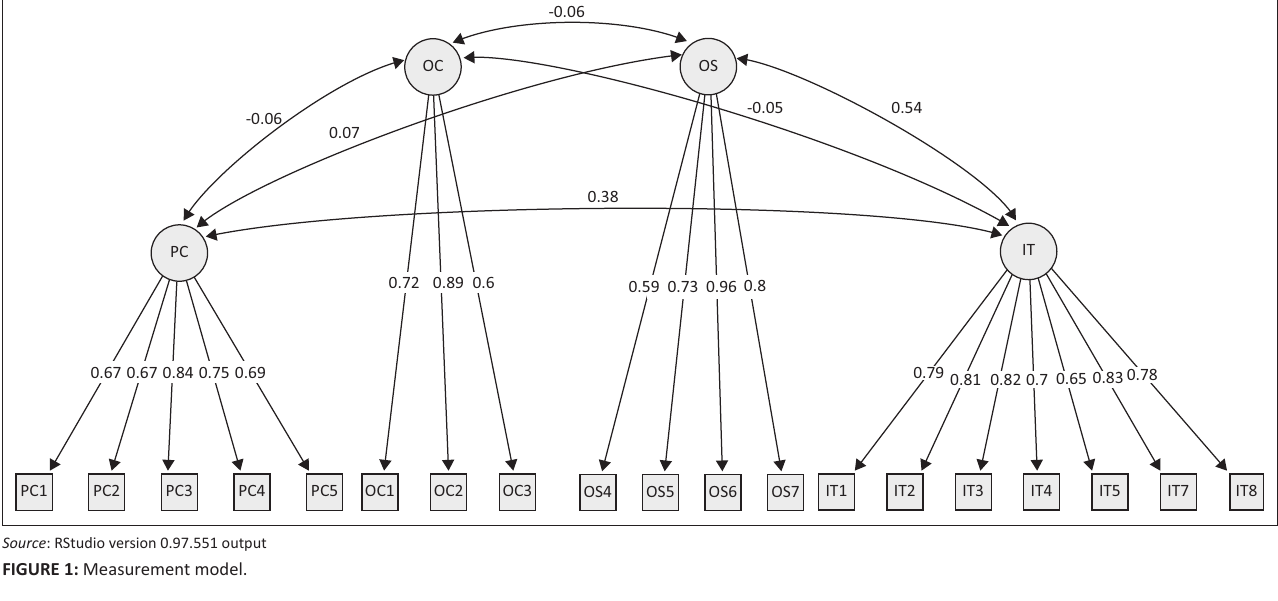
FIGURE 1 : Measurement